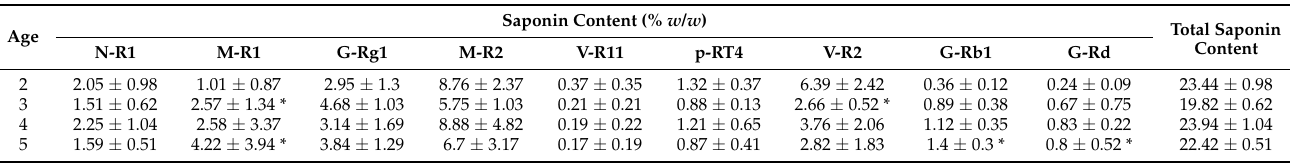
Table 3. The saponin content in rhizomes of 2–5 years old VGs detected by HPLC–CAD. Results are illustrated as mean ± standard deviation ( n = 5). * p < 0.05 compared with the age of 2.